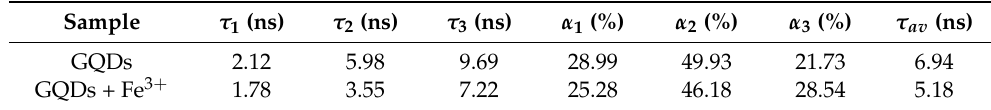
Table A2. Summarized lifetime values of graphene quantum dots (GQDs) and GQDs with 10 µ M of Fe 3 +